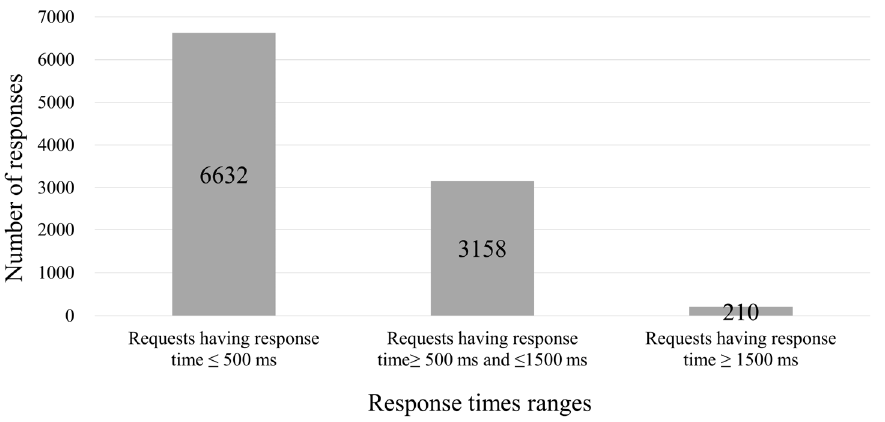
Figure 9. Statistics of system response time.